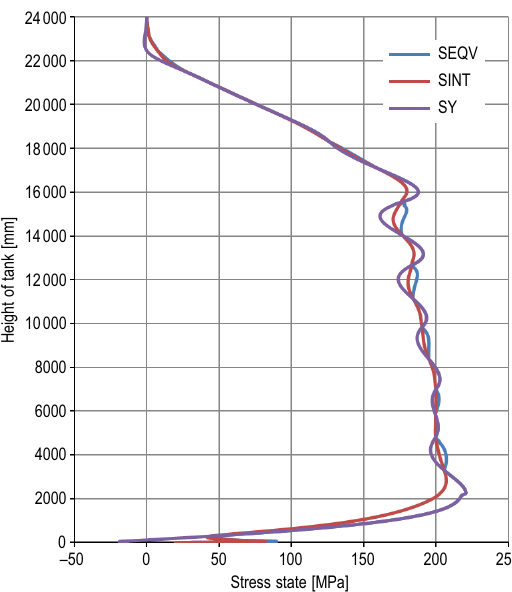
Fig. 11. Comparison of reduced membrane stress acc. to von Mises acc. to model